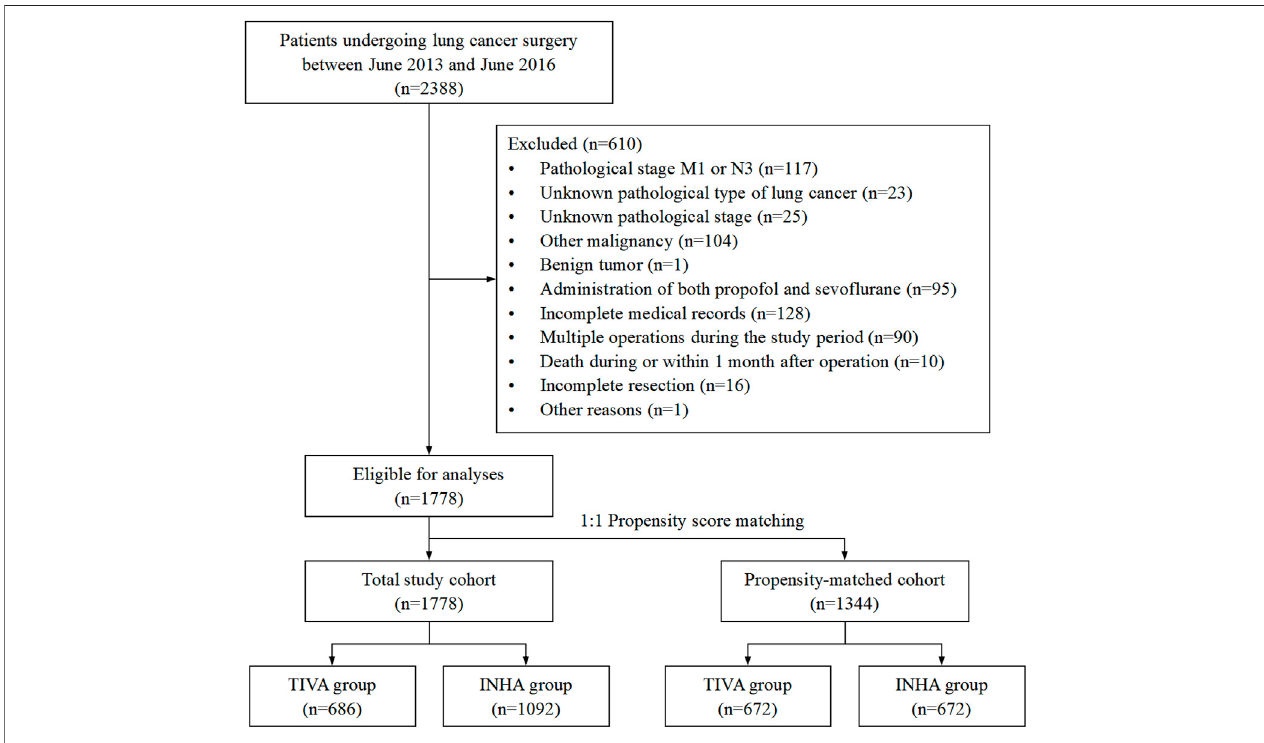
FIGURE 1 | Flow diagram of the study